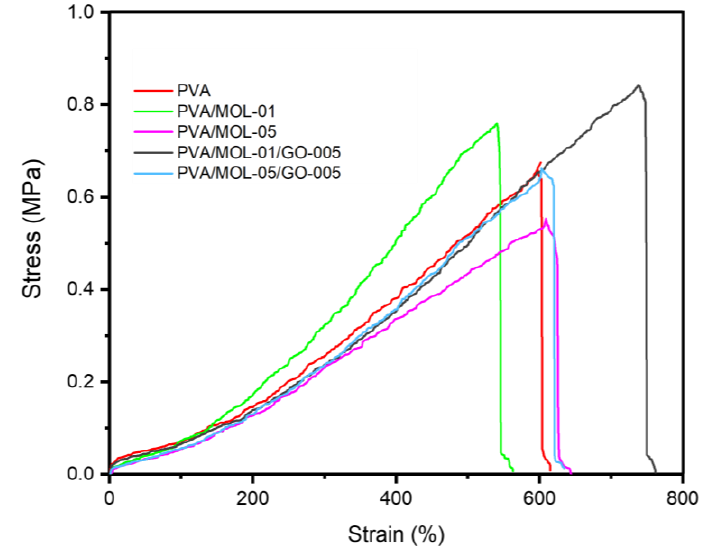
Figure 5. Stress–strain curve of all the Figure 5. Stress – strain curve of all the hydrogels. Table 1. Data of t he PVA/MOL/GO hydrogel tensile strength and stain.